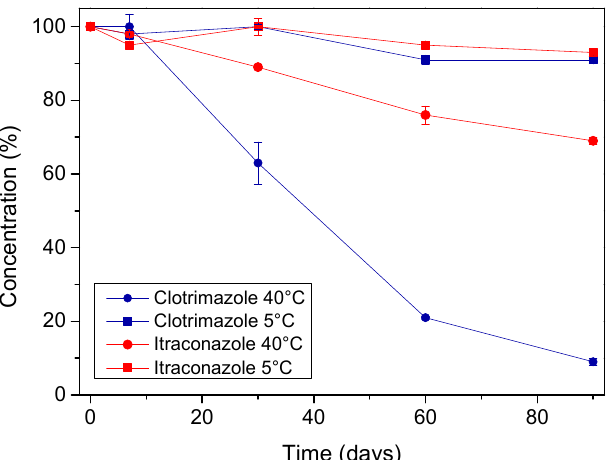
Figure 8. Graph showing the concentration of clotrimazole and itraconazole over time in different conditions. All data is represented as mean ± SD (n = 3).